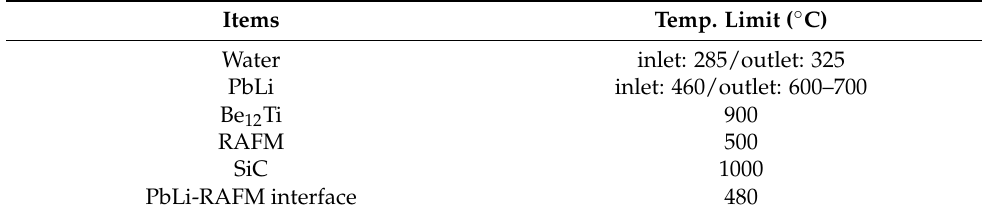
Table 1. Design criteria for thermal